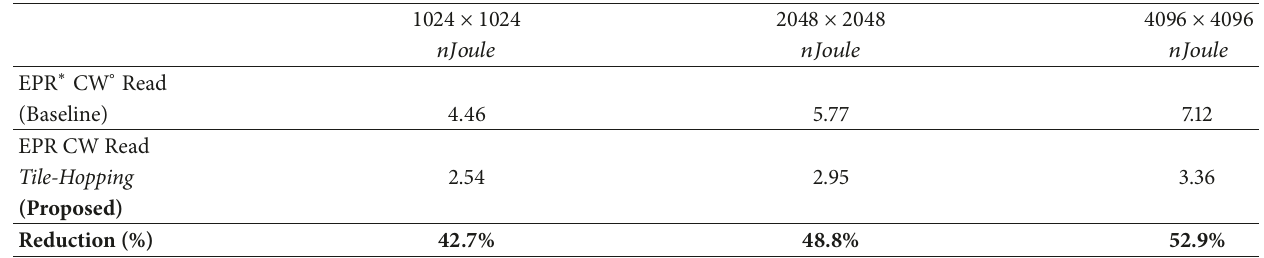
Table 3: DRAM energy consumption baseline vs tile-hopping.